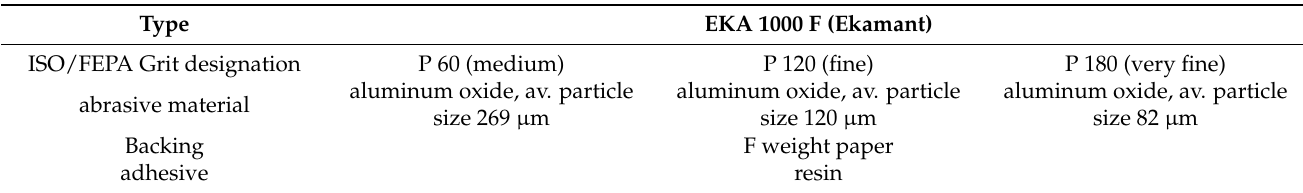
Table 2. Sand belts